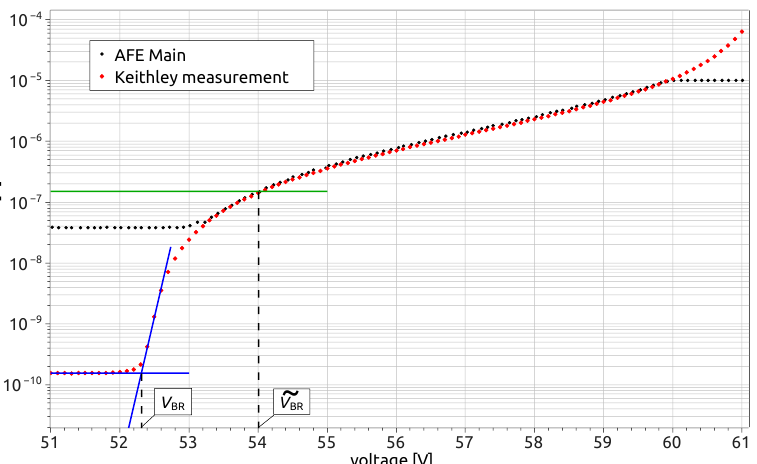
Figure 22. Current—voltage characteristics measured using Keithley electrometer and AFE internal meters. The green line represents current level at which (cid:103) V BR is determined. The intersection of the blue lines determines V BR